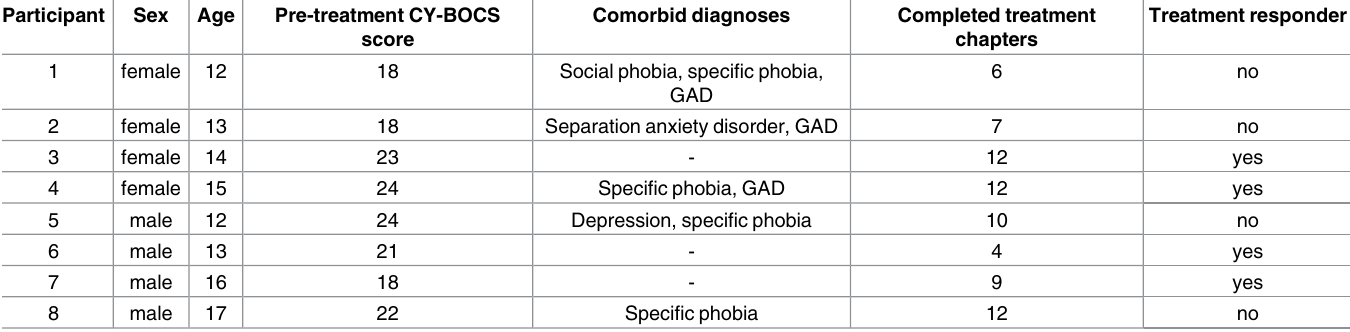
Table 1. Study 1 participant